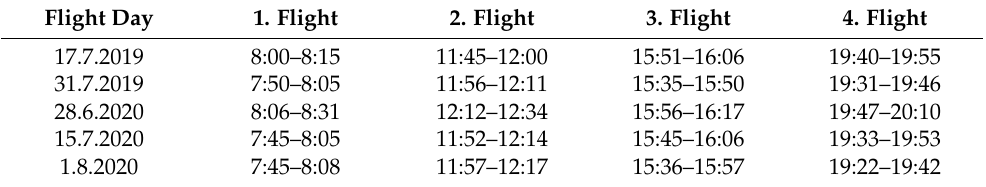
Table A1. The accurate flight times for each measurement flight made in 2019 and 2020. Flight Day